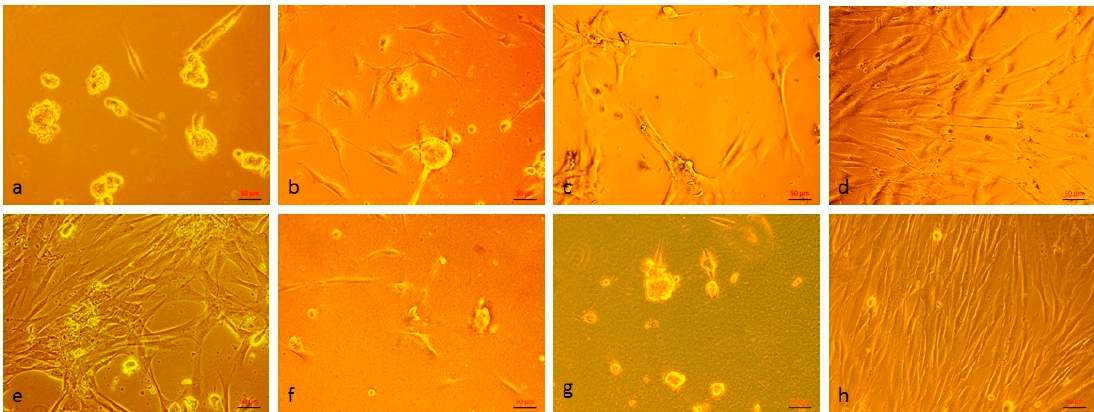
Figure 6. Human dermal fibroblasts were cultured on ( a ) chitosan (CS), ( b ) CS+0.5%CN (chitin), ( c ) CS+1%CN, ( d ) CS+5%CN, ( e ) CS+10%CN, ( f ) CS+20%CN, ( g ) CS+30%CN film matrices, and ( h ) cultural polystyrene surface (control) for 2 hours. Original magnification × 200, phase-contrast light microscopy, scale bar represents 50 μ m.